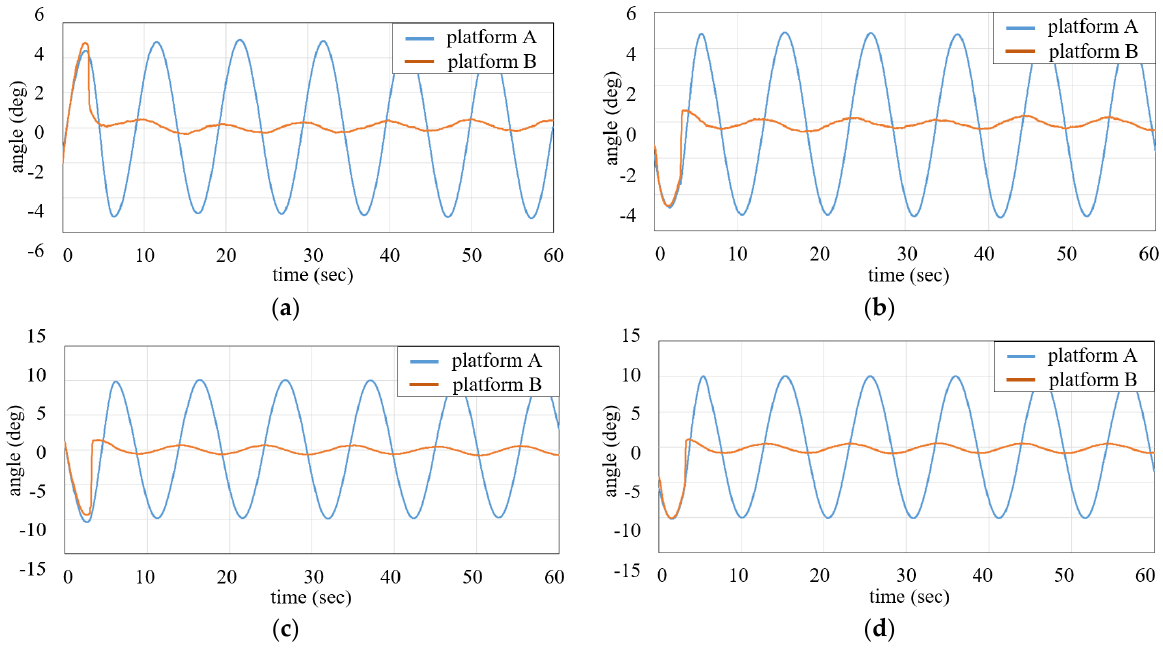
Figure 5. Self − stabilization in 1DOF sin motion condition. ( a ) Roll angle ≈ 5 deg; ( b ) Pitch angle ≈ 5 deg; ( c ) Roll angle ≈ 10 deg; ( d ) Pitch angle ≈ 10 deg. Table 2. Self-stabilization control errors in 1DOF motion conditions.